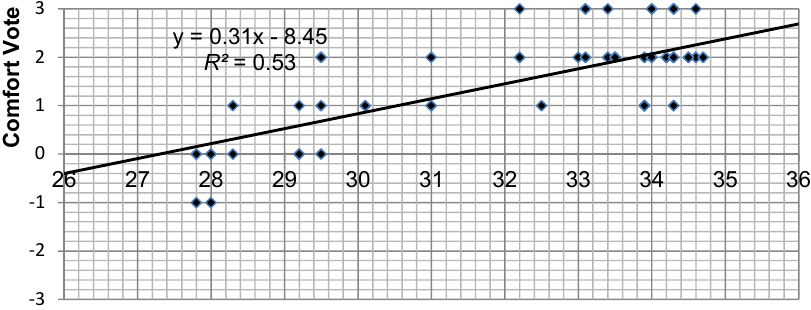
Figure 6. Regression line of thermal sensation vote on air temperature in the